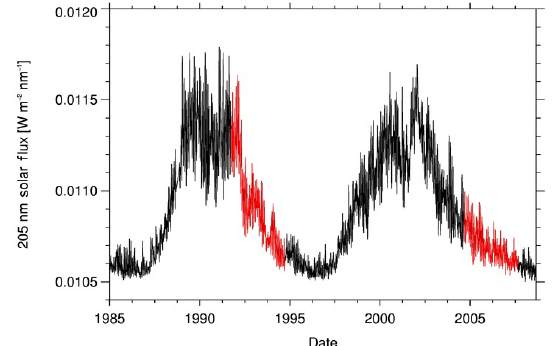
Figure 1. Temporal evolution of daily F205 from NRLSSI model over solar cycles 22 (1985–1996) and 23 (1996–2008). The two 3- year periods considered here (1991–1994 and 2004–2007) are high- lighted in